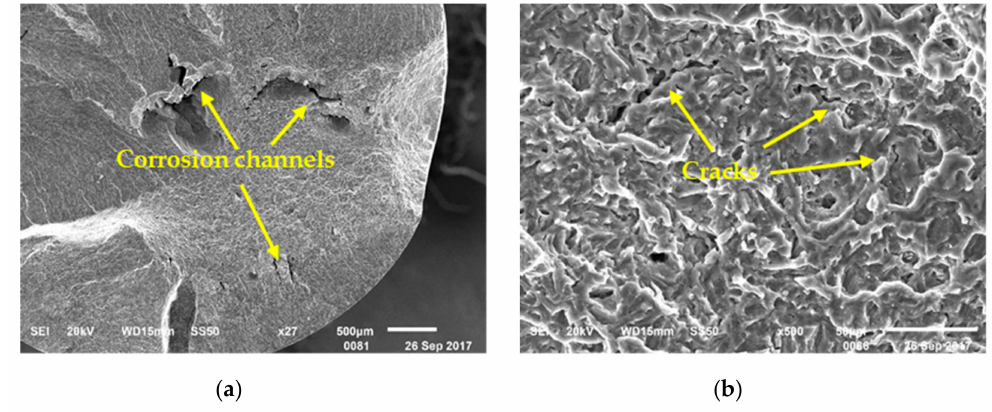
Figure 12. Fractographies of the SSRT test sample in 0.5 mol / L Na 2 SO 4 aqueous solution. ( a ) Overall, ( b ) Field in the